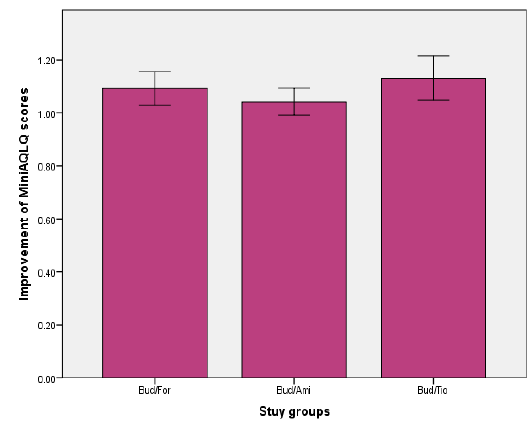
Figure 7. Comparison of groups according to extent of change in the MiniAQLQ scores during the first four weeks of study Bud/For (First group): Budesonide/Formoterol Bud/Ami (Second group): Budesonide/Aminophylline Bud/Tio (Third group): Budesonide/Tiotropium The second four weeks revealed that the third group produced significantly higher improvement in MiniAQLQ scores compared to first and second groups (p=0.004, p<0.001 respectively). Also, the first group was associated significantly with larger extent of improvement compared to the second group (p<0.001) as shown in figure 8.